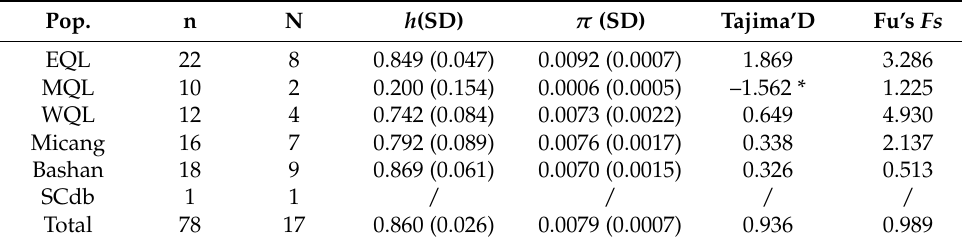
Table 2. Genetic diversity and neutral test of wild boar population.